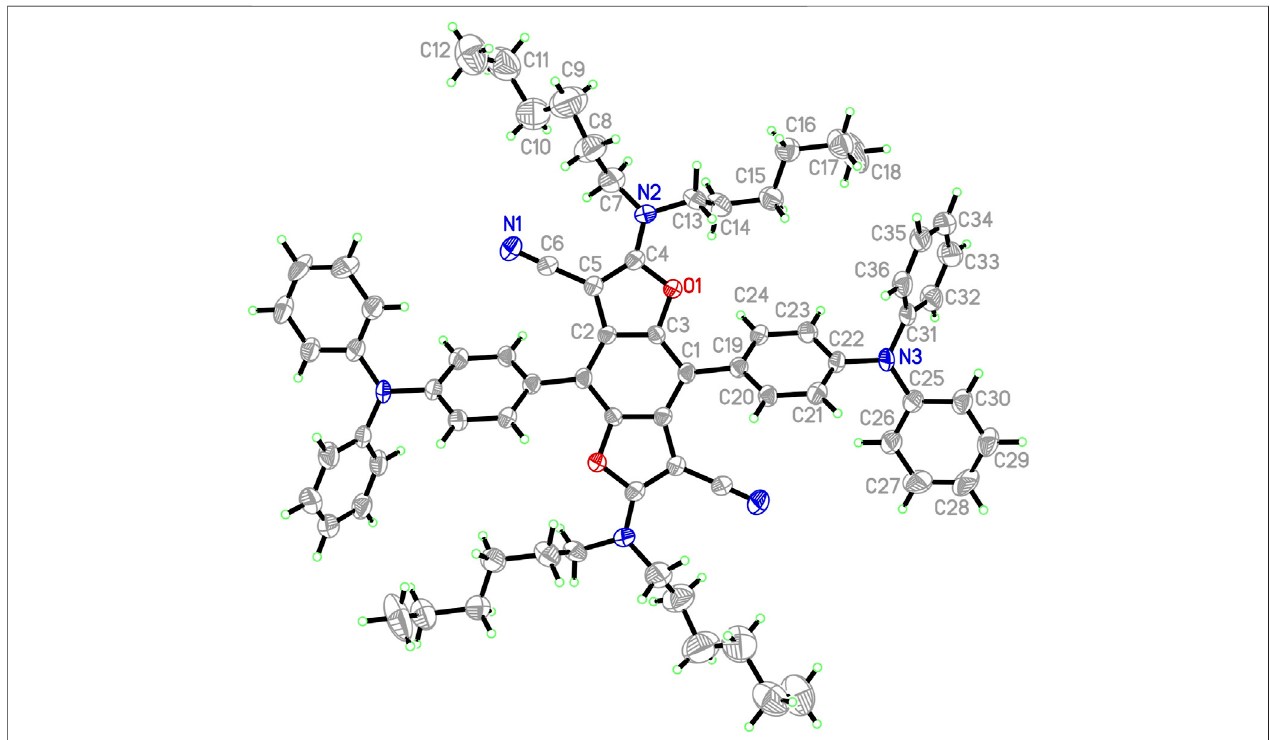
FIGURE 2 | ORTEP representation of one independent molecule 2 (50% probability ellipsoids; H-atoms given arbitrary displacement parameters for clarity).